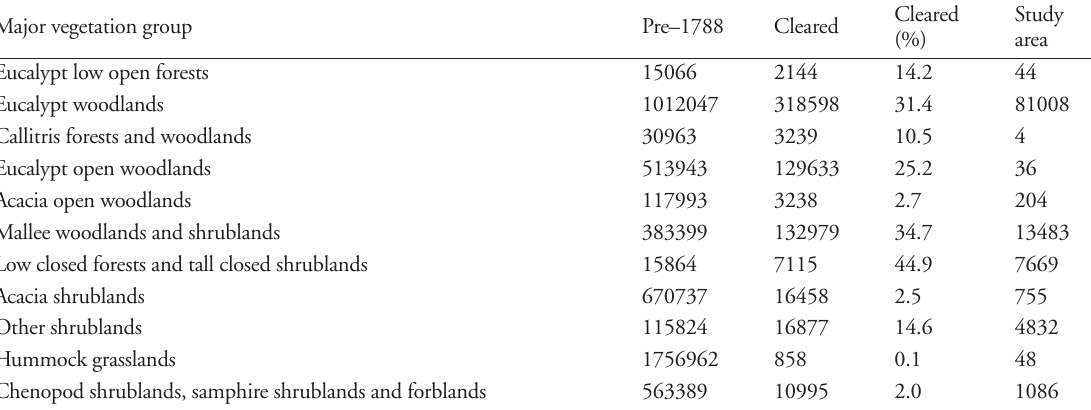
Table 2. The continental area (km 2 ) of both pre-European (1788) and current (2001), vegetation cover of each of the 11 major vegeta- tion groups found in study area according to the National Vegetation Inventory (Commonwealth of Australia 2001). The area (km 2 ) cover of each group within the study area is also